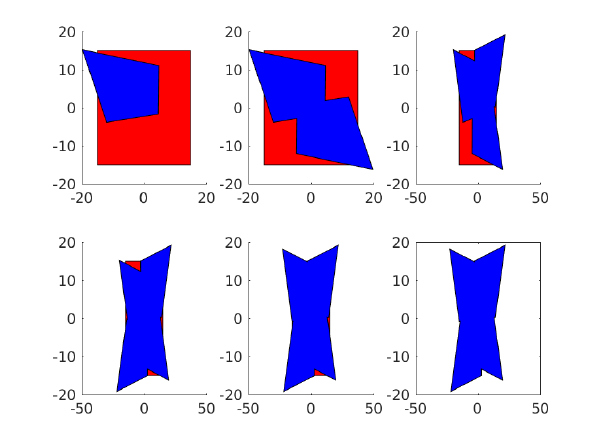
Figure 6. The placement of cameras for the greedy algorithm. The blue region denotes what area the camera can see, and the red region denotes the region of interest we wish to